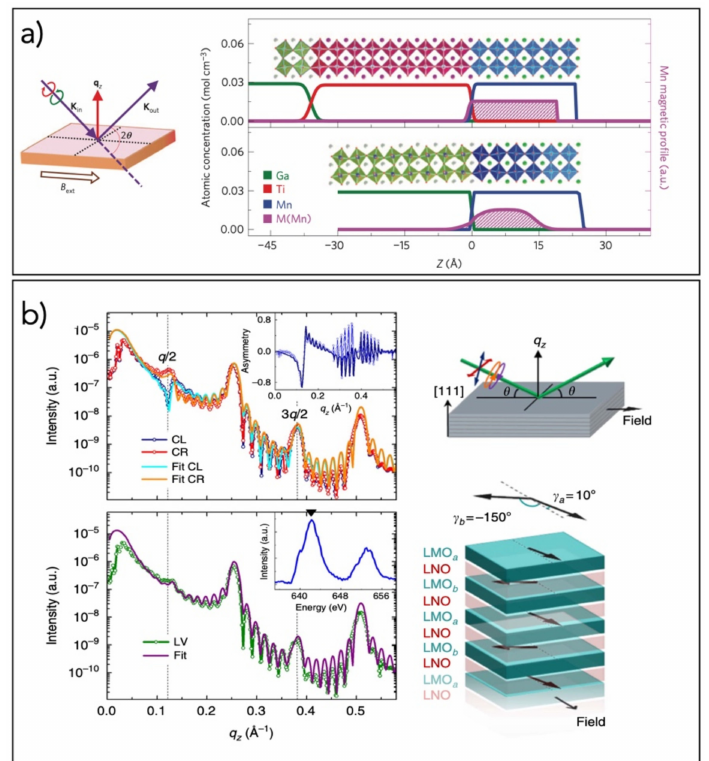
Figure 4. ( a ) Atomic concentration depth profiles of Ga, Ti, Mn (green, red, and blue lines, respec- tively), and Mn magnetization (M, purple line with shaded area) obtained at 20 K on LSMO films with (top panel) and without (bottom panel) a STO buffer layer; the panel on the left shows the ex- perimental geometry, where a 0.6 T magnetic field was applied in-plane along the magnetic easy axis during the measurement (reprinted with permission from Springer Nature, Nature Materials, [61], Copyright (2016)); ( b ) from [64]: top left, reflectivity for circularly left (CL, blue line) and right (CR, red line) polarized light taken on a LaNiO 3 /LaMnO 3 superlattice; inset, extracted asymme- try ratio (CR − CL)/(CR + CL); bottom left, reflectivity with linearly vertical (LV) polarized light; inset, Mn L 2,3 X-ray absorption spectrum, the arrow indicates the energy at which the reflectiv- ity measurements were performed; top right, schematic of the scattering geometry for reflectivity measurements; bottom right, depiction of the extracted magnetic